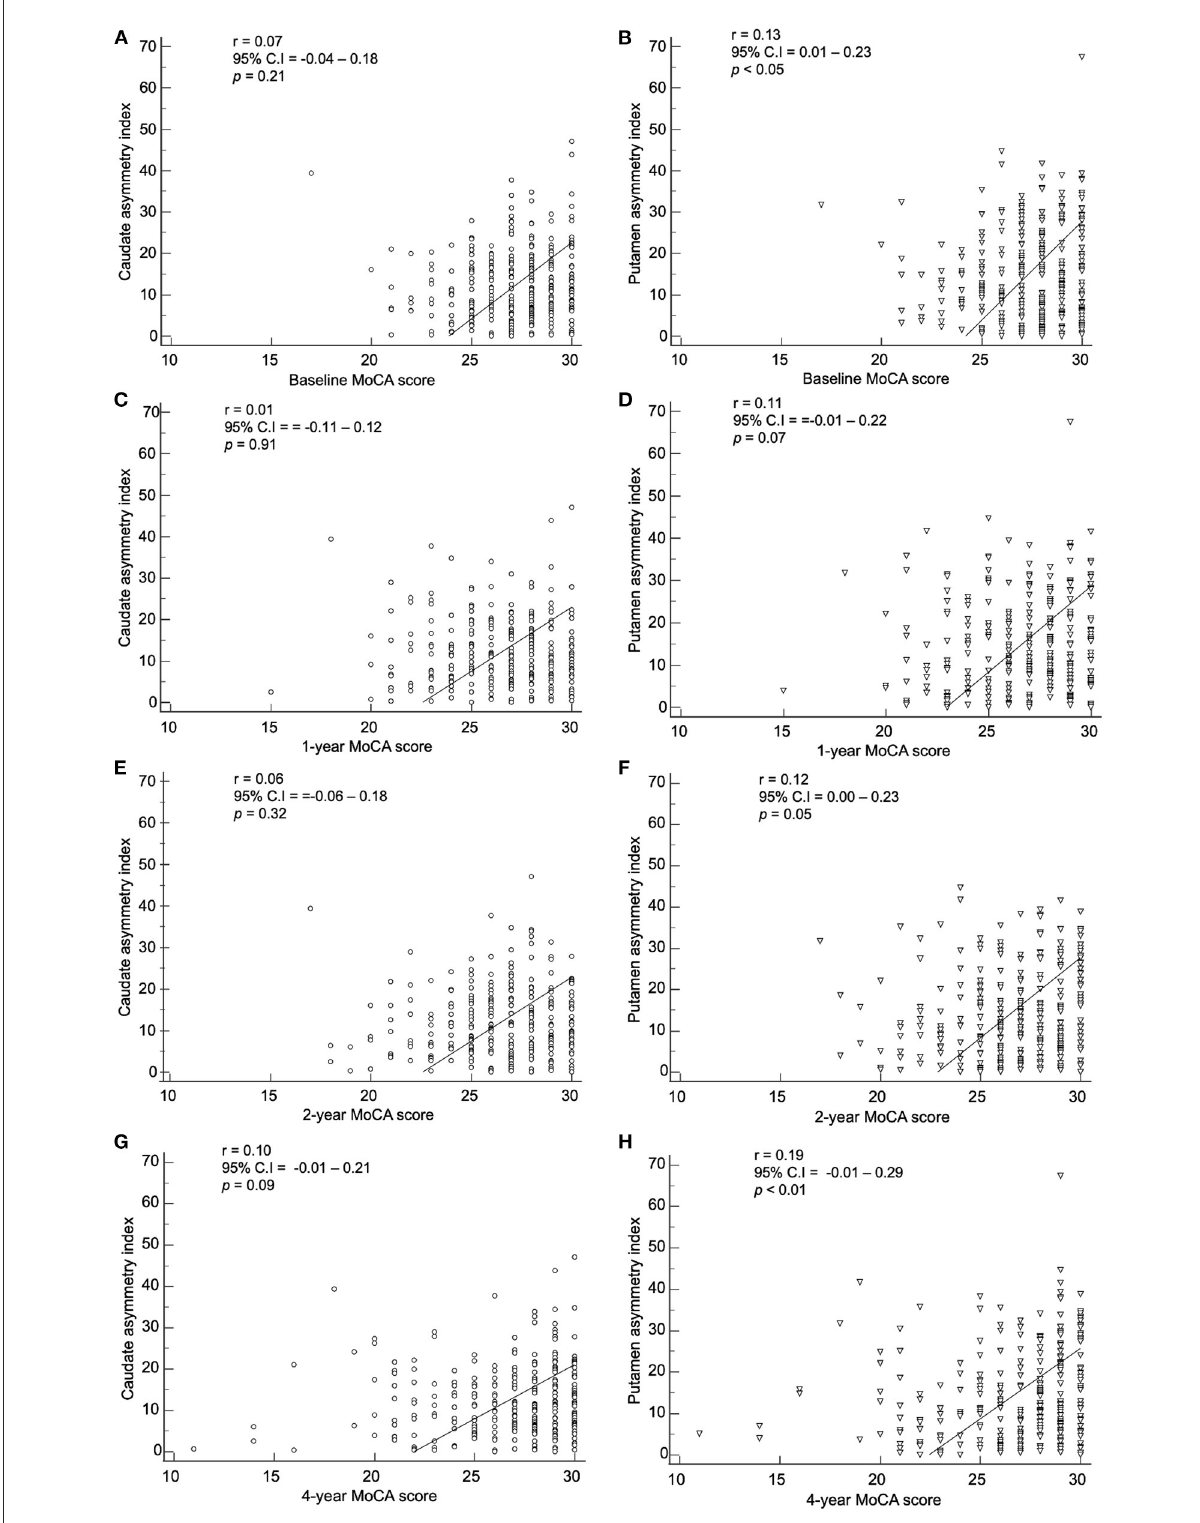
FIGURE8 Correlation of the baseline asymmetry index of the caudate by method 2 with (A) baseline, (C) 1-year, (E) 2-year, and (G) 4-year MoCA scores. Correlation of the baseline asymmetry index of the putamen by method 2 with (B) baseline, (D) 1-year, (F) 2-year, and (H) 4-year MoCA